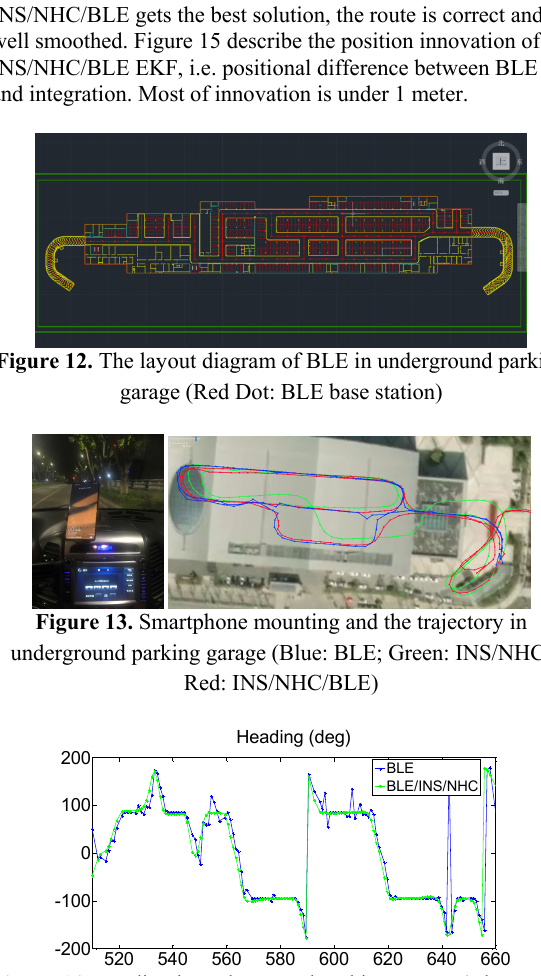
Figure 14. Heading in underground parking garage (Blue: BLE; Green: BLE/INS/NHC integration)